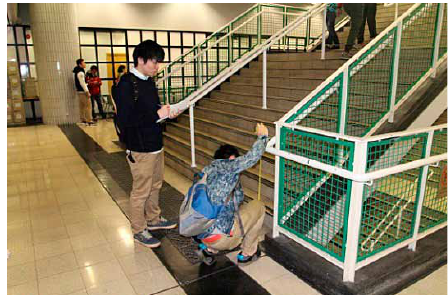
Fig. 6. On-site evaluation of physical disability